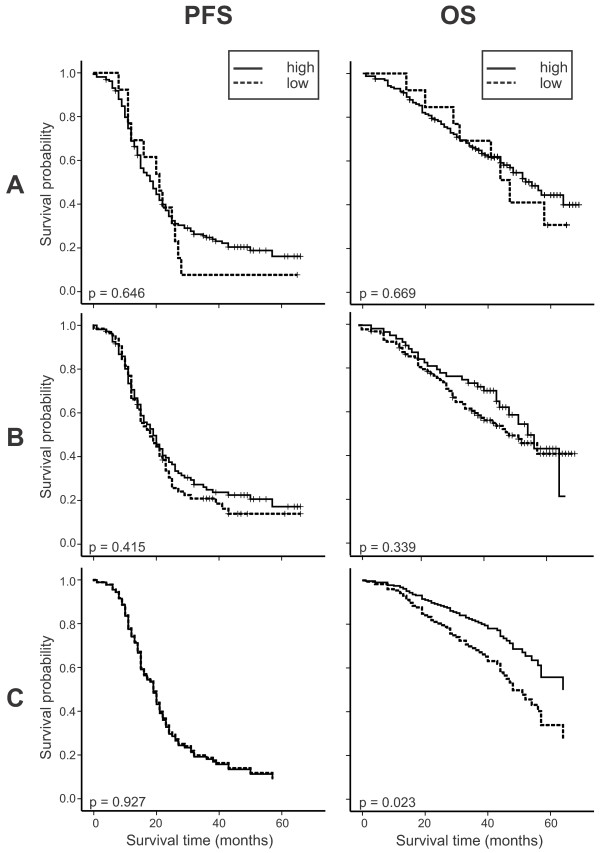
Kaplan–Meier estimates of the univariate impact of FAK (A) and (B) pFAK-Y397 and survival curves of the final Cox regression model (C), corrected for the clinicopathologic parameters age, stage, grade, residual tumor load, peritoneal carcinomatosis, and molecular subclass (i.e. all of these factors were averaged and pFAK was used as stratifying variable) on progression free and overall survival. In contrast to Kaplan-Meier plots, where it is common to indicate censored observations, Figure 1C shows survival estimates derived from the Cox model, as explained in the statistical analysis section. In this plot it is uncommon to graphically show censored observations. pFAK low, n = 90 versus pFAK high, n = 50 patients.